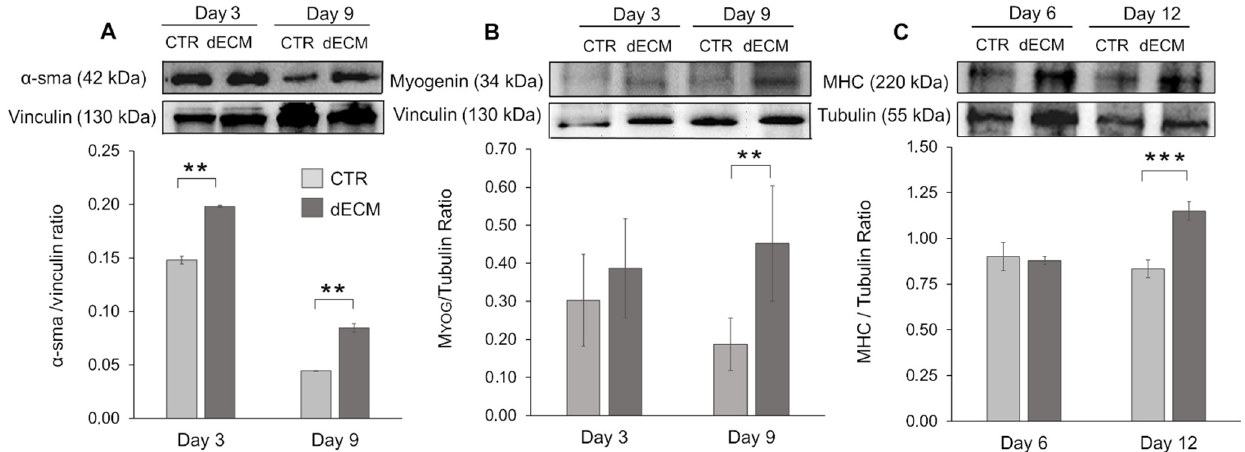
Figure 8. Expression of myogenic markers, analyzed by Western blot. C2C12 myoblasts were incubated either on uncoated (CTR) or dECM pre-coated wells and induced to differentiate in differentiation medium. At different time points the contents of α -smooth muscle actin ( A ), myogenin ( B ), and MHC ( C ) were measured by Western blots of whole cell lysates and the intensity of the bands quantified, relative to the housekeeping proteins vinculin or tubulin used to normalize. Representative Western blots out of the three for each condition are shown. Statistics were determined by t -test. ** p < 0.01, *** p < 0.001.